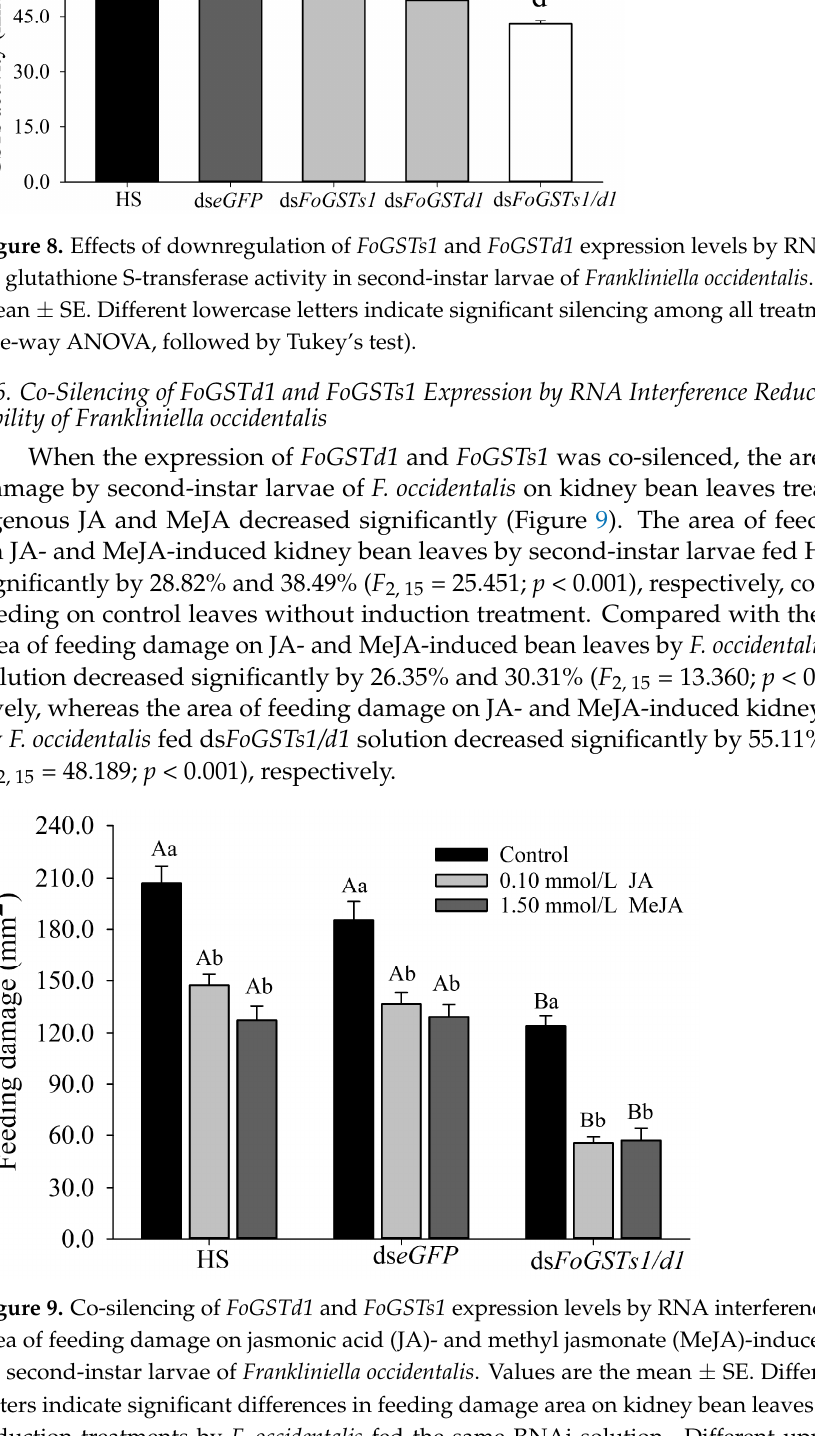
Figure 7. Downregulation of FoGSTd1 and FoGSTs1 expression levels in second-instar larvae of Frankliniella occidentalis when fed dsRNA solutions. ( a ) Relative expression level of FoGSTd1 ; ( b ) Relative expression level of FoGSTs1 . Values are the mean ± SE. Different lowercase letters indicate significant silencing among all treatments ( p < 0.05; one-way ANOVA, followed by Tukey’s test).